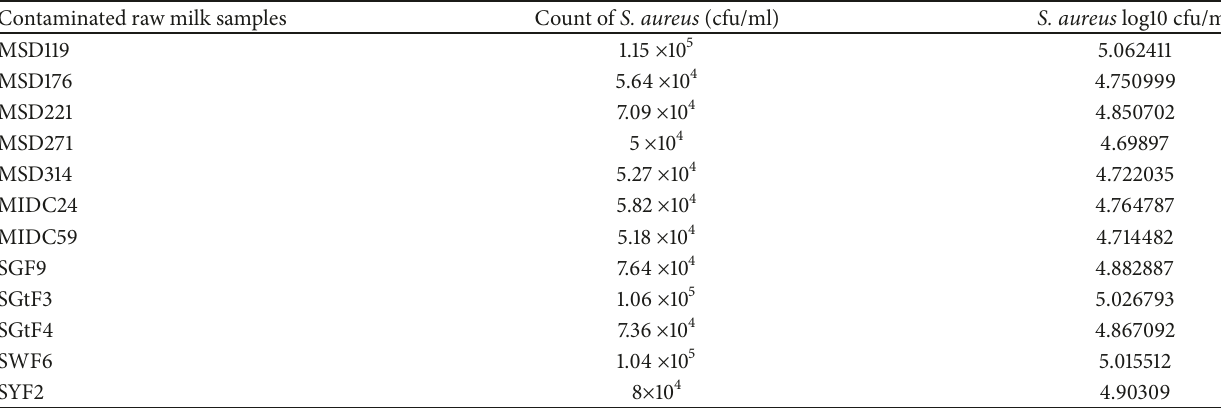
Table 6: Staphylococcus aureus load from raw milk collected directly from